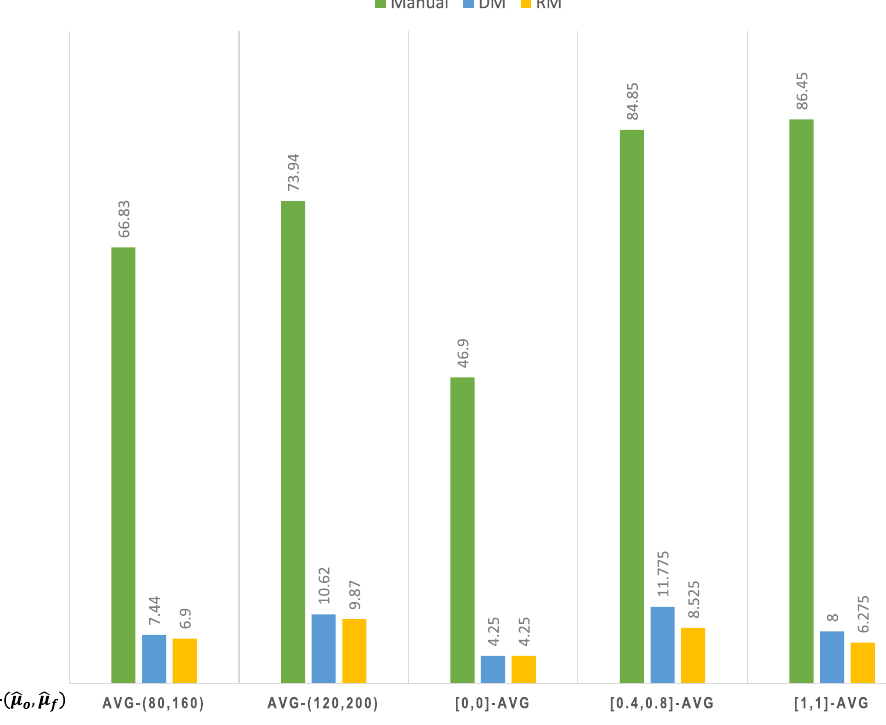
Figure 2. Variance of realized working time spent among delivery workers.